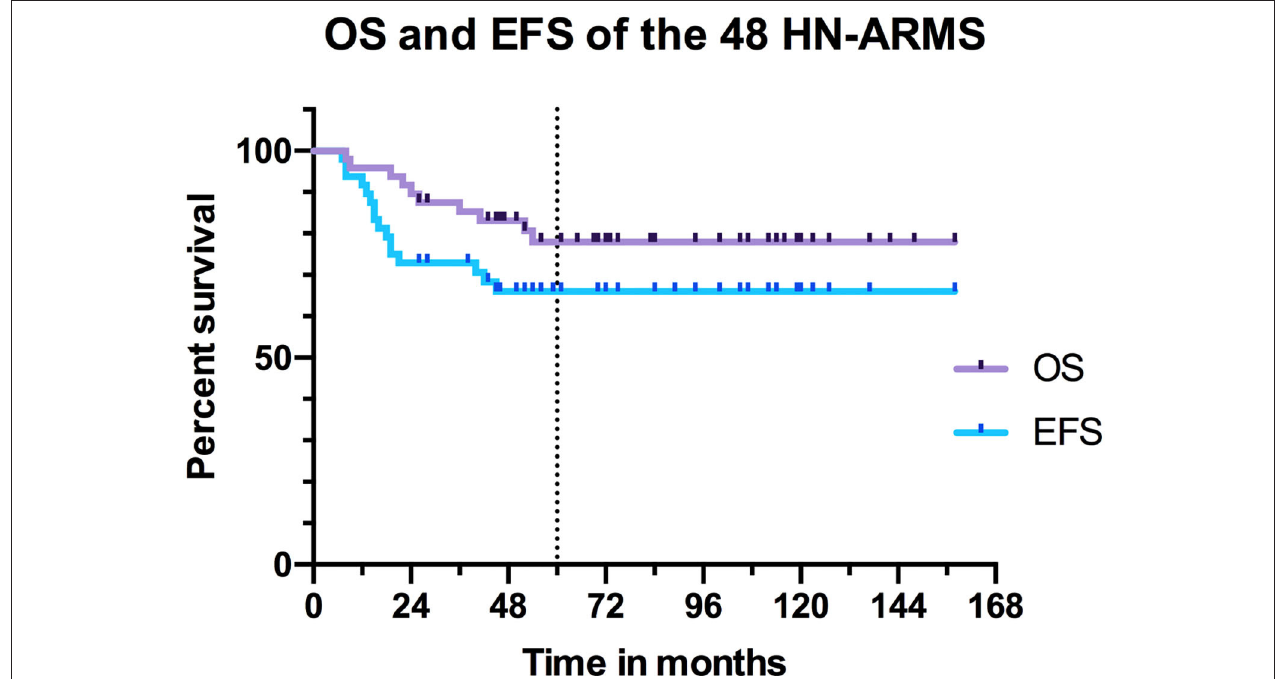
FIGURE 6 | Overall survival and event-free survival of the 48 patients with head and neck alveolar rhabdomyosarcoma (HN-ARMS).